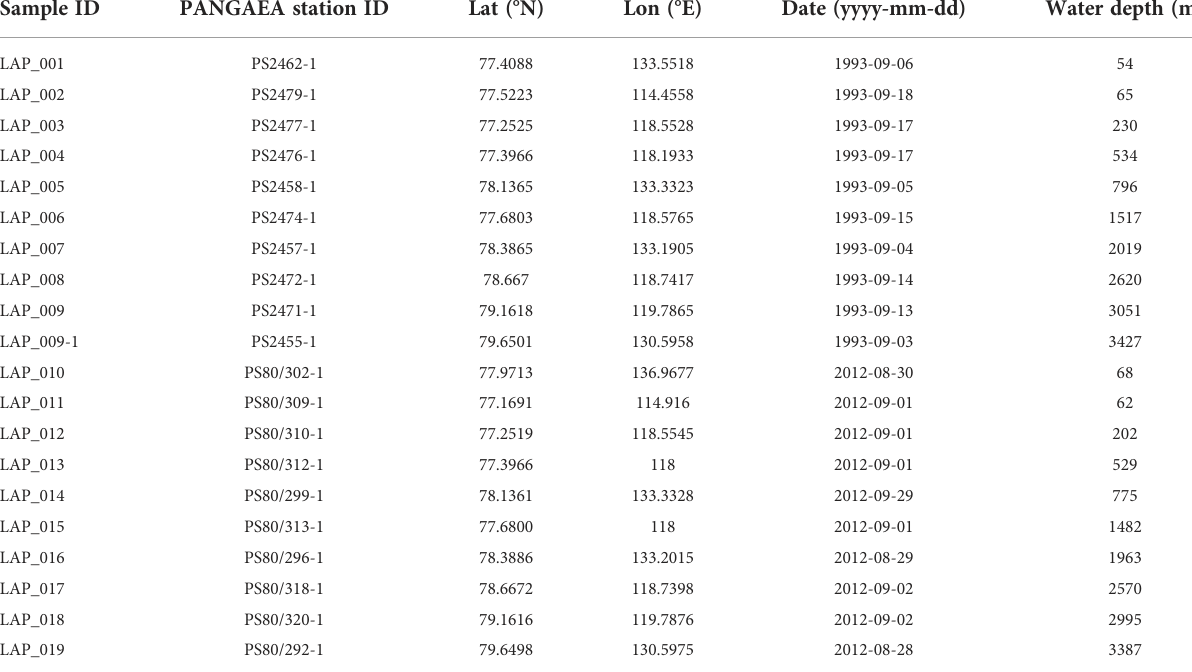
TABLE 1 Benthic stations down the Laptev Sea continental slope, sampled in September 1993 and August/September